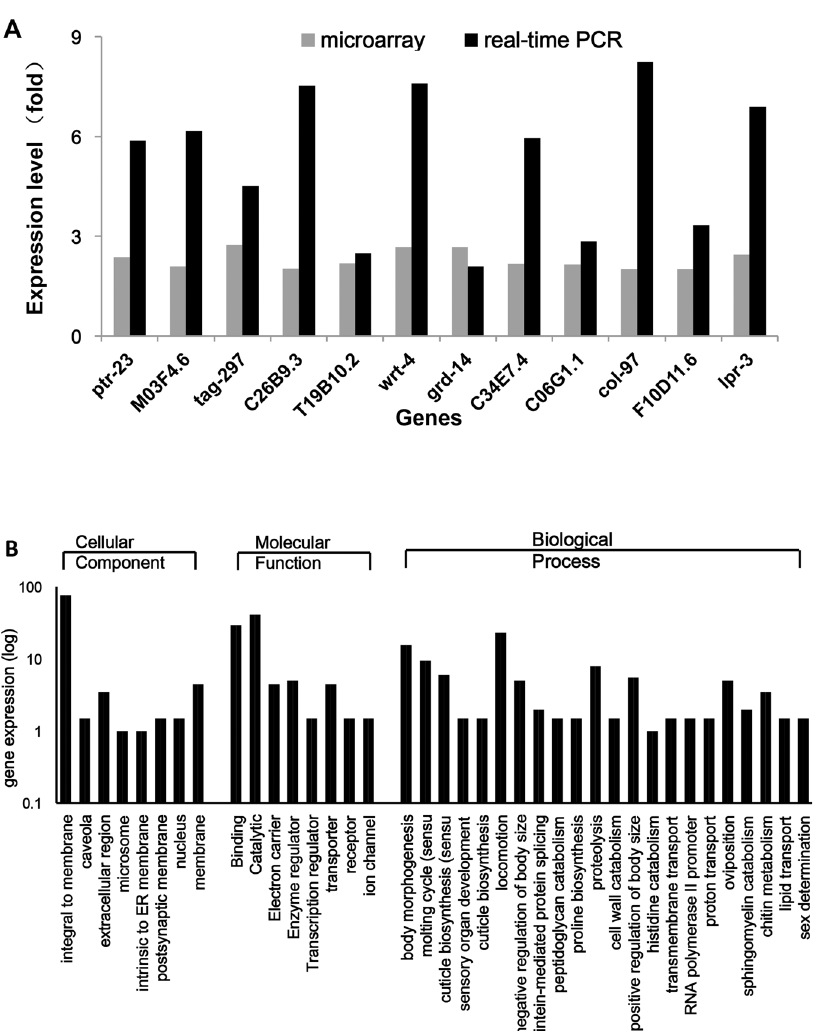
Fig 3. Relative expression of various genes in C . elegans fed with pET28a-r Bm α TX14. (A) The gene expression changes were detected through Affymetrix Genechip profiling. qRT-PCR analysis also confirms the differential regulation of genes identified through microarray analysis. qRT-PCR was used to examine changes in gene expression. (B) Molecular annotation system analysis of the genes. The differentially expressed genes were classificated of by GO-term